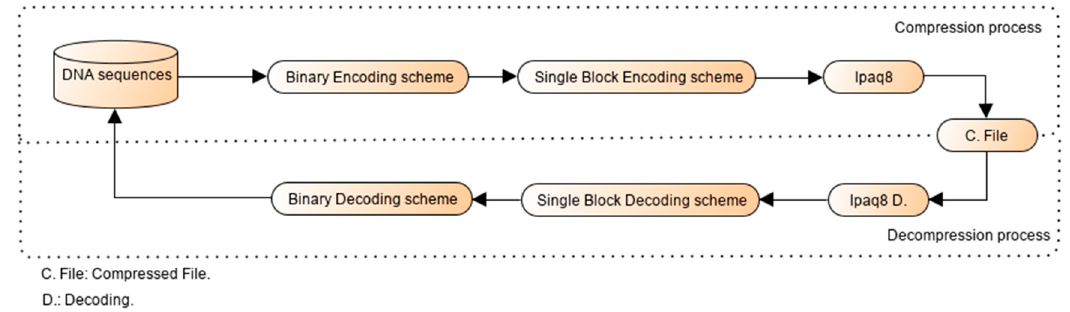
Figure 1. An overview of the proposed algorithm.